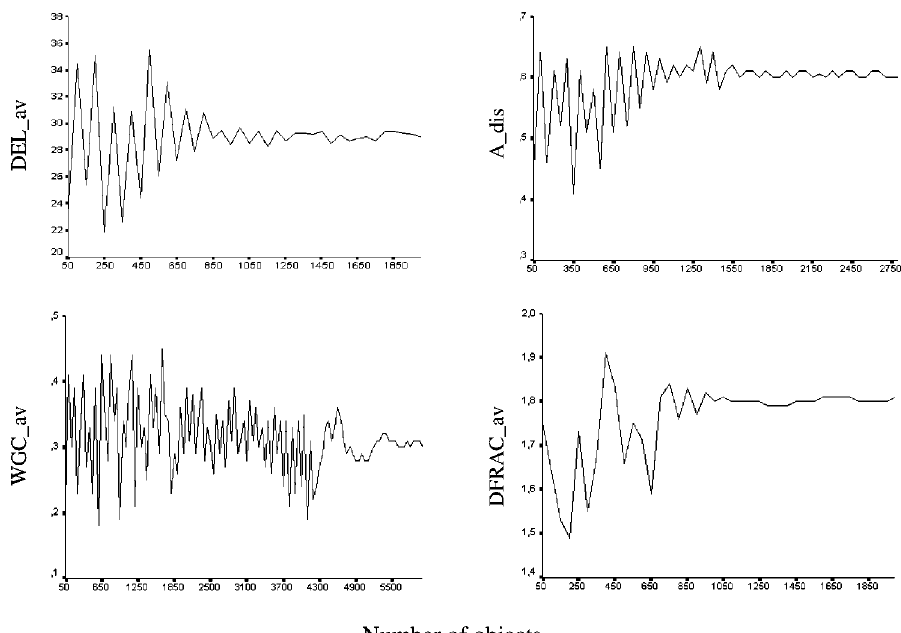
Fig. 1. The absolute values of the four structural features (DEL_av, A_dis, WGC_av and DFRAC_av) as a function of the number of cells analyzed when computed in a case of carcinoma of the prostate. The number of objects (cells) required to achieve reproducible values (CV < 5%) varies considerably from one structural feature to another.